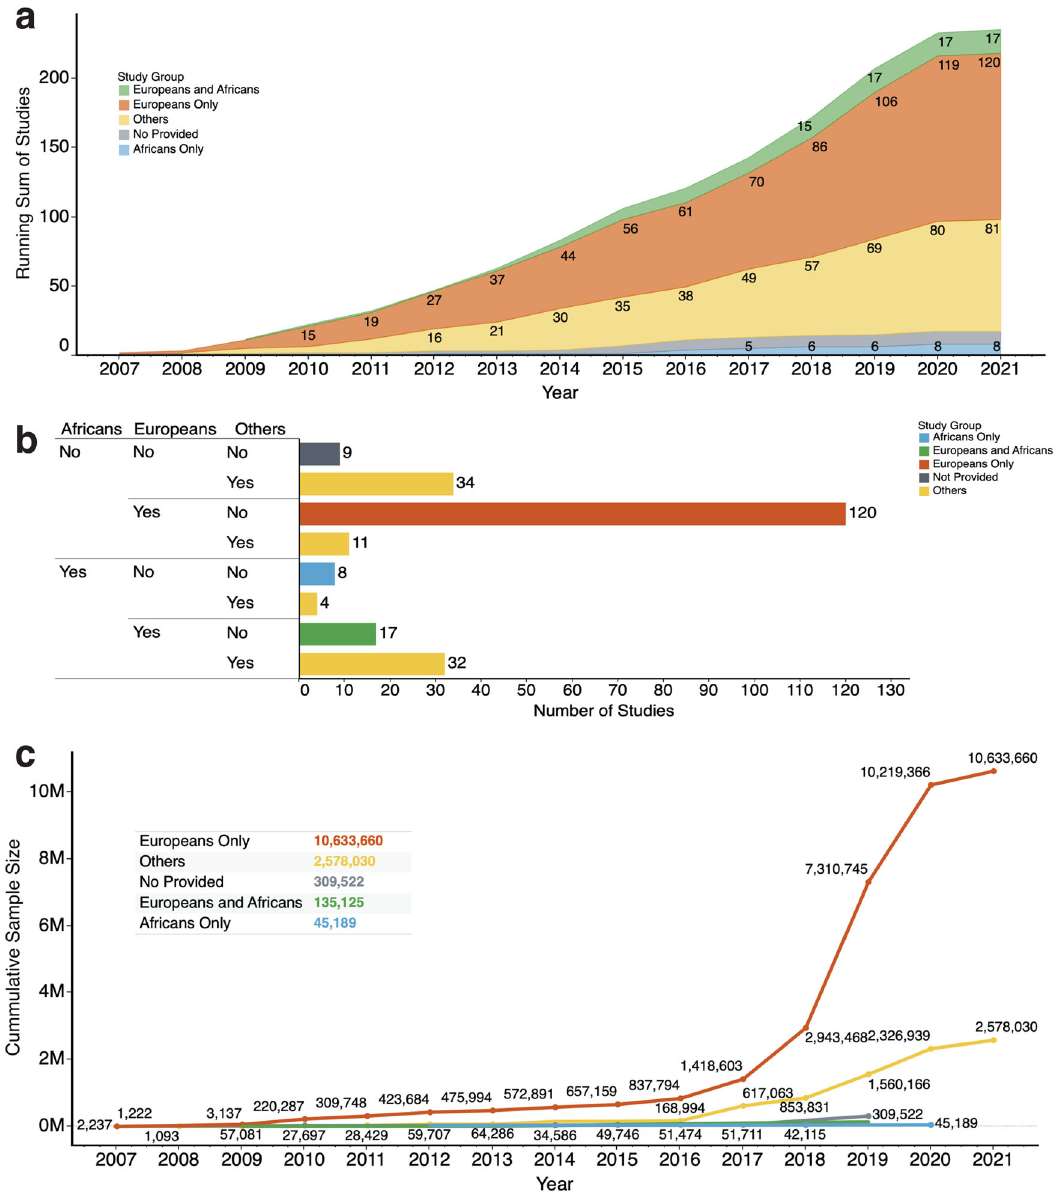
Fig. 5 The GWAS catalog of pulmonary function and lung phenotypes studies. a The plot of the running sum of GWAS studies reported from 2007 to 2021. The colours show details about the race/ancestry groups: Africans only, Europeans only, Europeans and Africans, Others, and those for which the race/ancestry group is “ Not provided ” . b The total number of GWAS studies reported for each race/ancestry group combination. The colours depict information about race and ethnic groups. c The trend of the cumulative sum of participants (on the y -axis) of studies from 2007 to 2021. The colours show details about the race/ancestry groups. The marks are labelled by the cumulative sum of participants. The fi gure insert shows the total number of participants by race/ancestry Methods Comparison of pulmonary function parameters in Europeans and Africans . We compare the mean values of the pulmonary function parameters FVC, FEV1, and We analysed a UK Biobank 11 dataset of 383,471 individuals of European ancestry PEF between 383,471 Europeans and 5978 Africans using the Welch t-test. Fur- (designated as White, British, Irish, and “ any other white background ” ) and 5978 thermore, to evaluate how FVC, FEV1, PEF, and FEV1/FVC values vary with the individuals of recent African ancestry. The UK biobank obtained all participant participant ’ s body mass index, height, and age, we calculated the 10th percentile samples and body measurements from consenting individuals. Information on the bins of each anthropometric measurement and visualised the trend using error bars UK biobank ethics policy and approval can be found here: https://www.ukbiobank.ac. plotted for each percentile. uk/learn-more-about-uk-biobank/about-us/ethics.The demographics of the UK Bio- bank participants are extensively described elsewhere 11 . The data elements we ana- lysed include genotyping array data of imputed SNPs, anthropometric measurements, and pulmonary function parameters: FVC, FEV1, and PEF. The ancestry groups were initially de fi ned by self-identi fi cation. Then, a principal component analysis was performed, followed by a random forest on the projected principal component Furthermore, the genotyping quality control implemented for the analyses is analysis data to reassign the initial self-de fi ned ancestries of individuals with a described at the following link https://pan.ukbb.broadinstitute.org/docs/qc. We membership posterior probability >0.5. Other individuals with a posterior probability obtained the GWAS summary statistics computed by the UK Biobank project for less than 0.5 for any given ancestry group were dropped from further analysis. each pulmonary function parameter. The methods used to perform the GWA